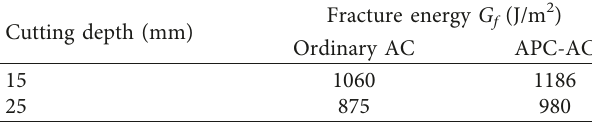
Table 9: Results of the semicircular splitting tests. Cutting depth